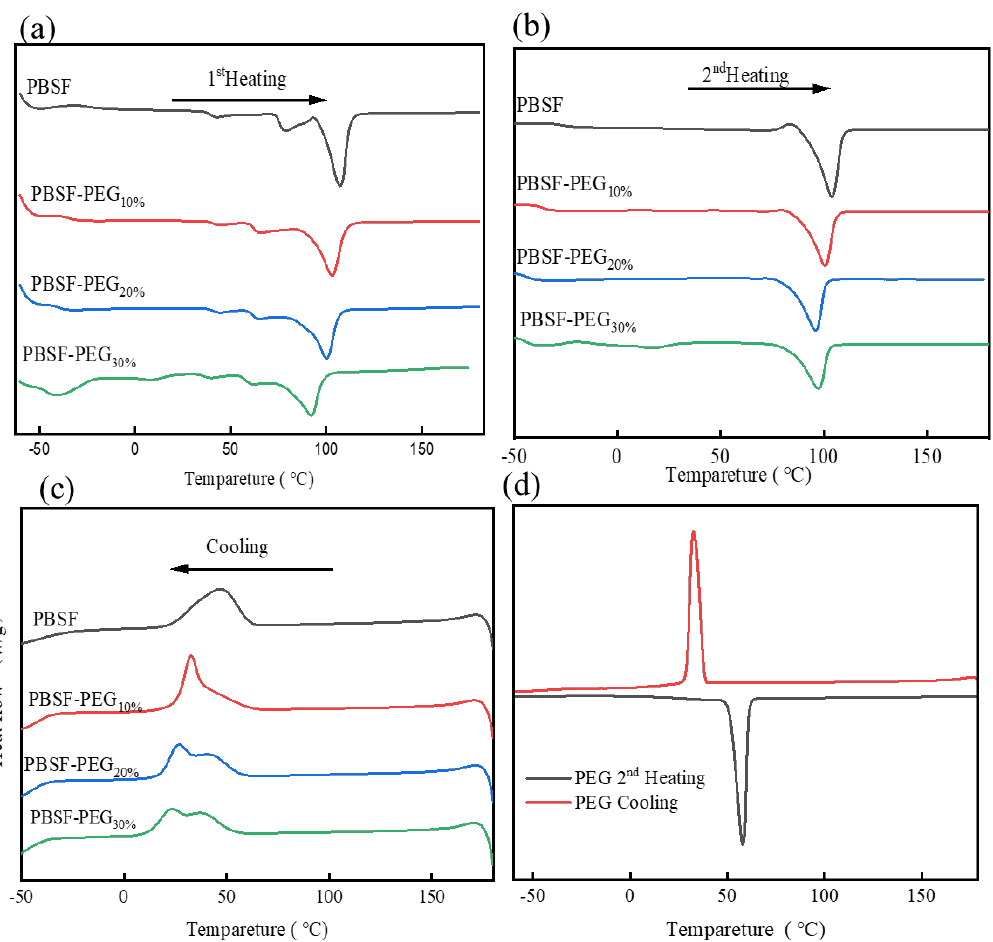
Figure 4. DSC curves of ( a ) first heating, ( b ) second heating, and ( c ) cooling. ( d ) PEG second heating and cooling.